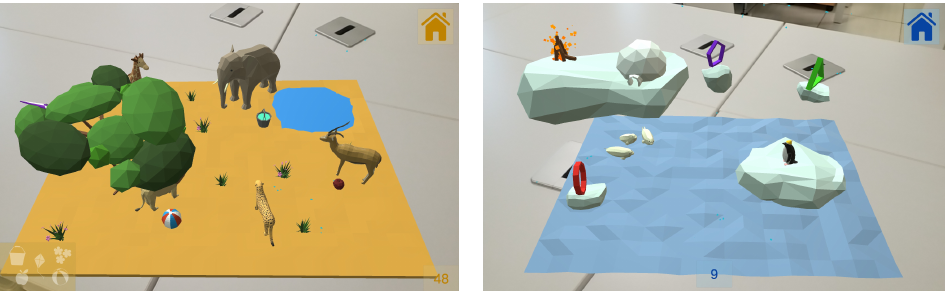
Figure 10. Screenshot from the “Savannah ” and “North Pole”